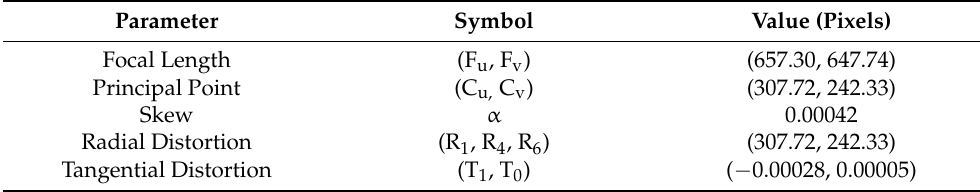
Table 1. Example parameters in the MAVS camera distortion model.